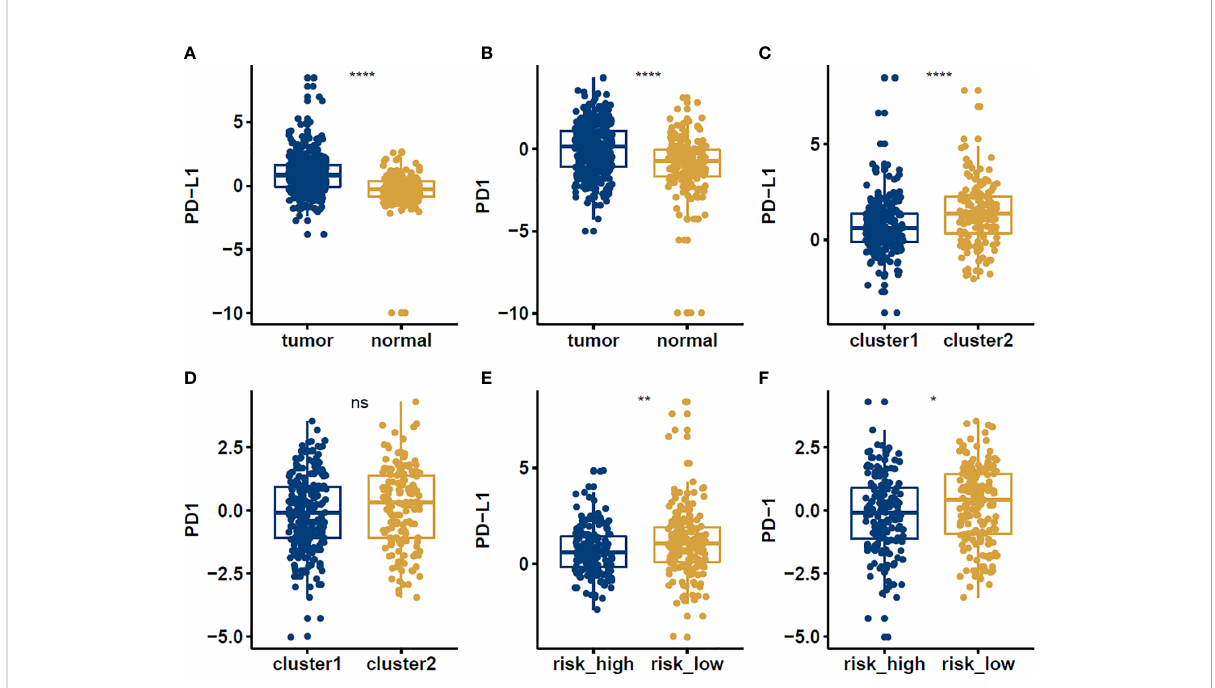
FIGURE 8 The expression levels of PD-1 and PD-L1 in normal vs tumor (A, B) , cluster1 vs cluster2 (C, D) , high risk vs low risk (E, F) groups in STAD patients. *p<0.05; **p<0.01; ****p<0.0001, ns: no signi fi